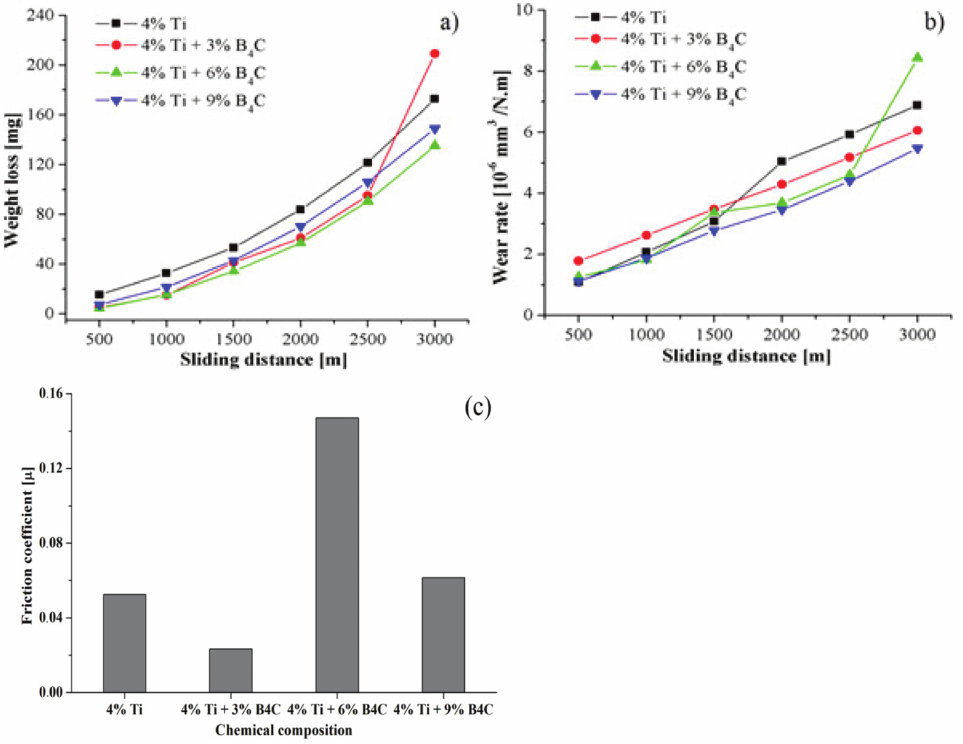
Figure 4: Weight losses (a), wear rates (b) and friction coefficients (c) of hybrid composites produced using powder metallurgy under 30 N